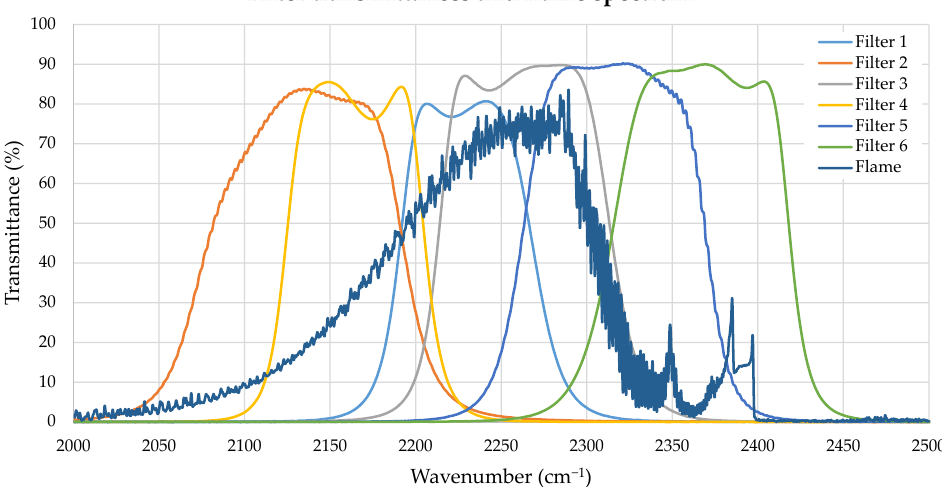
Figure 5. Transmittance in the mid − IR region of the six interference filters used, with a emission spectrum of a the standard flame (in arbitrary units) shown for